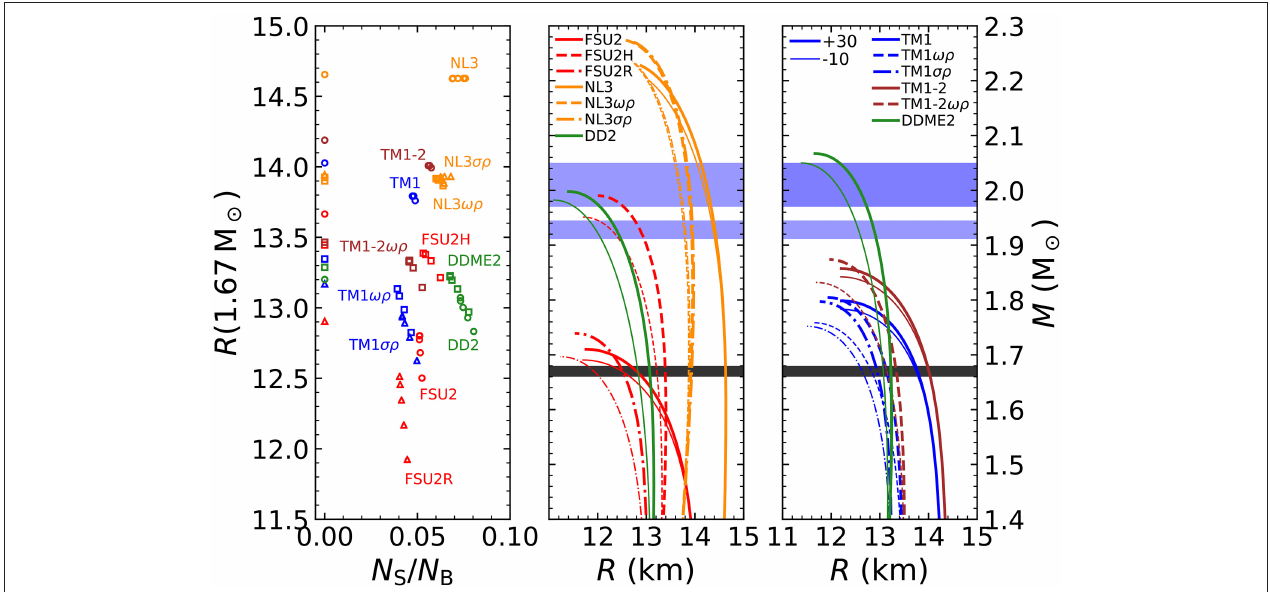
FIGURE 11 | (Left) Radius of a 1.67 M 20, and 30 MeV. (Middle, Right) M